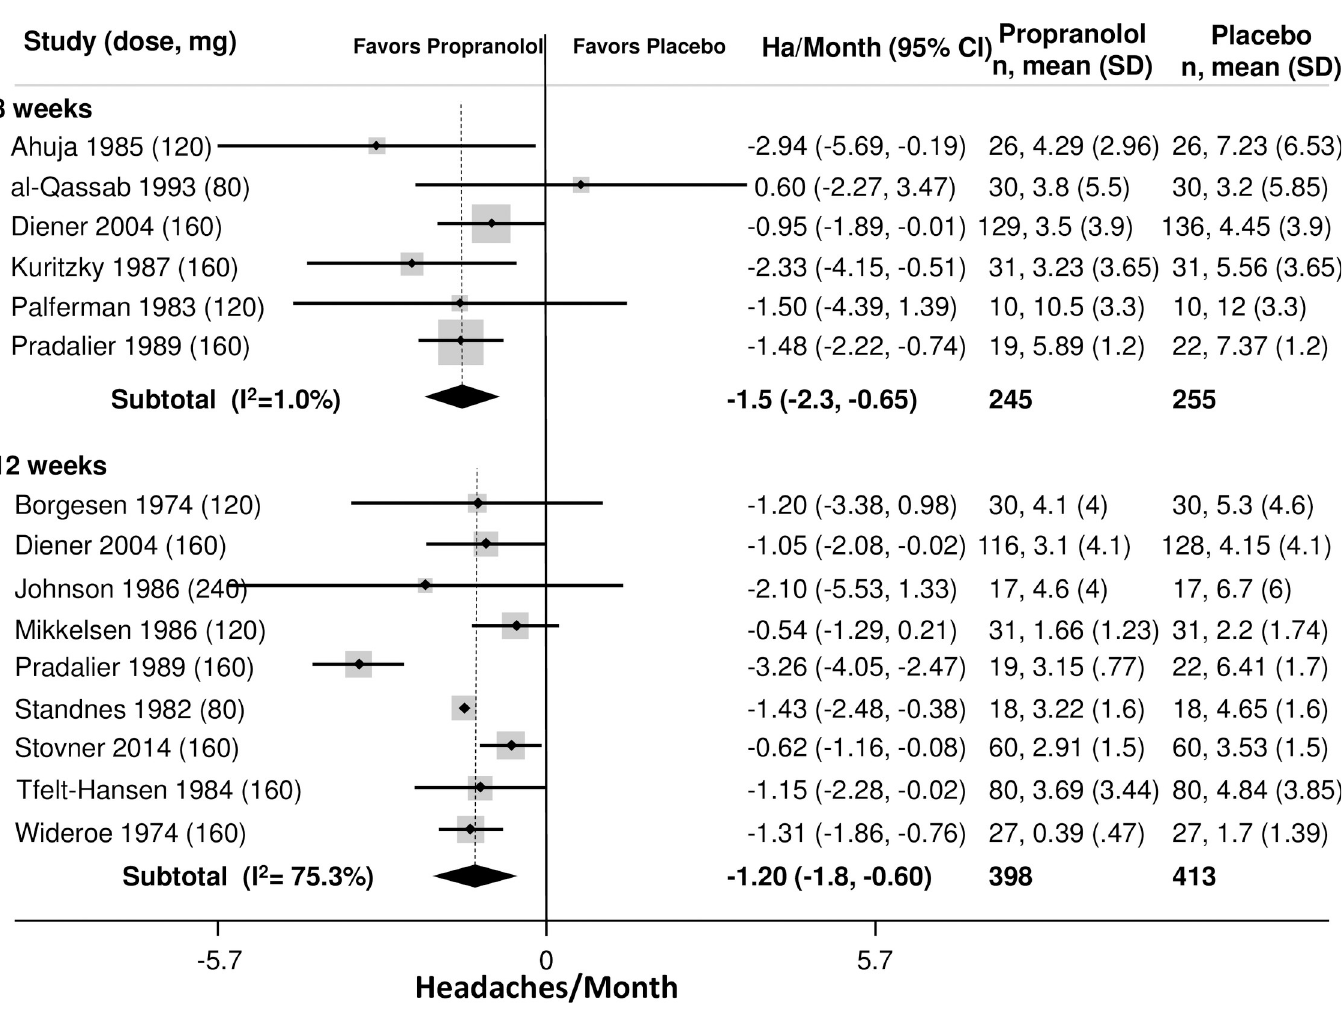
Fig 2. Headaches per month, Propranolol v.